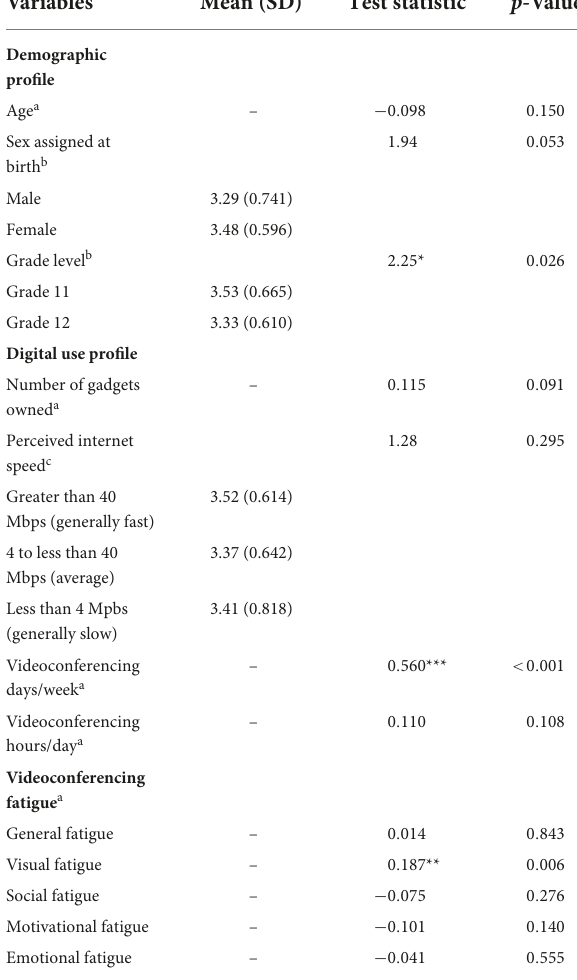
TABLE 3 Bivariate statistics on the correlation of demographic profile, digital use profile, and videoconferencing fatigue with online student